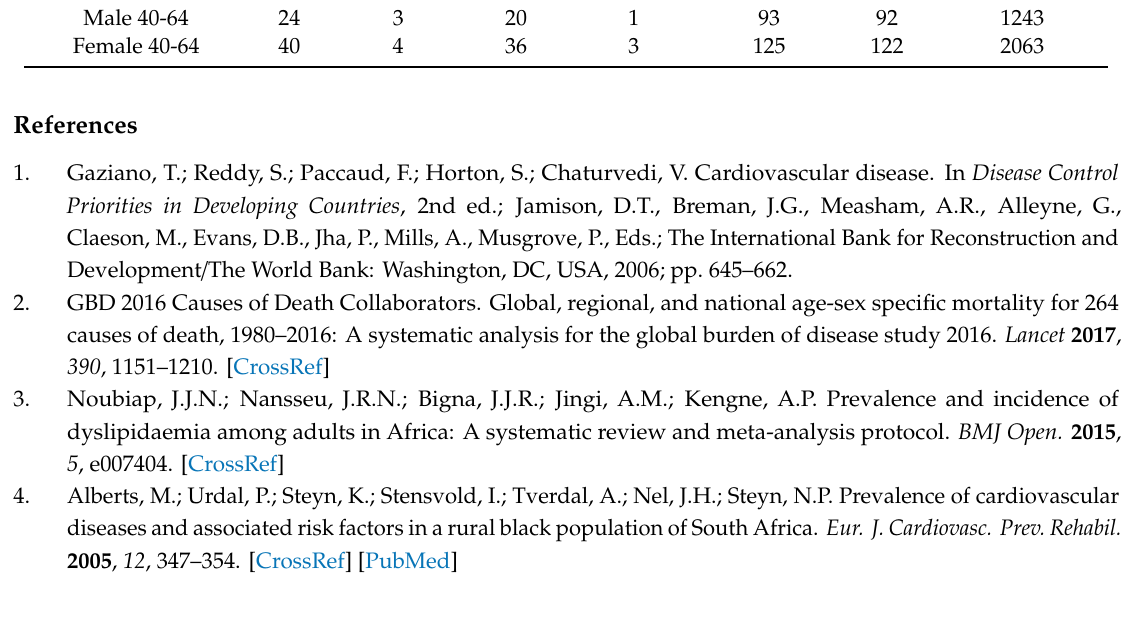
Figure A3. Spatial Clusters of Prevalence of five CVDs and their risk factors.